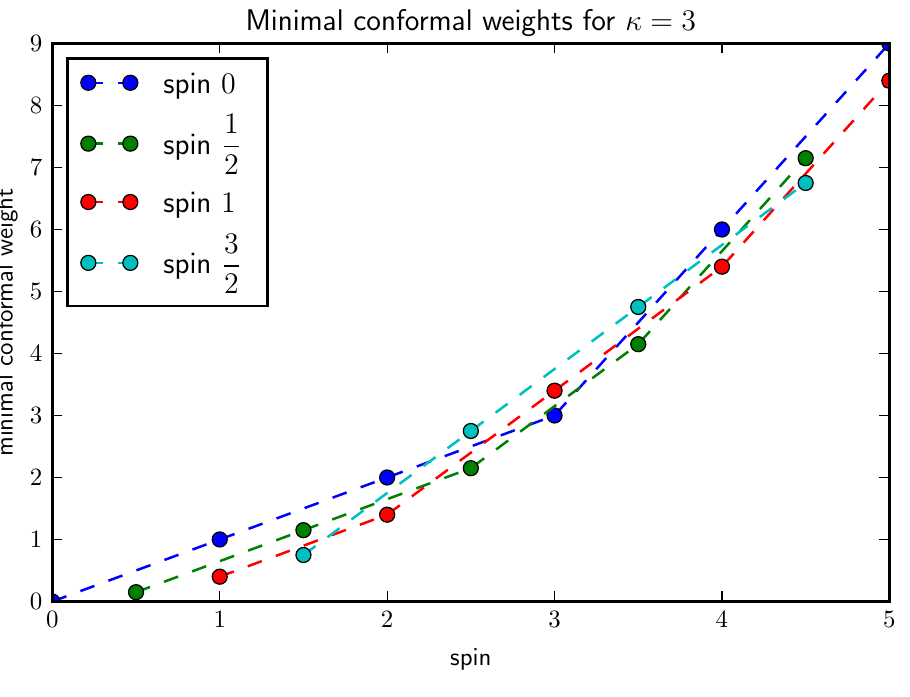
Figure 1 . Minimal conformal weight for a given